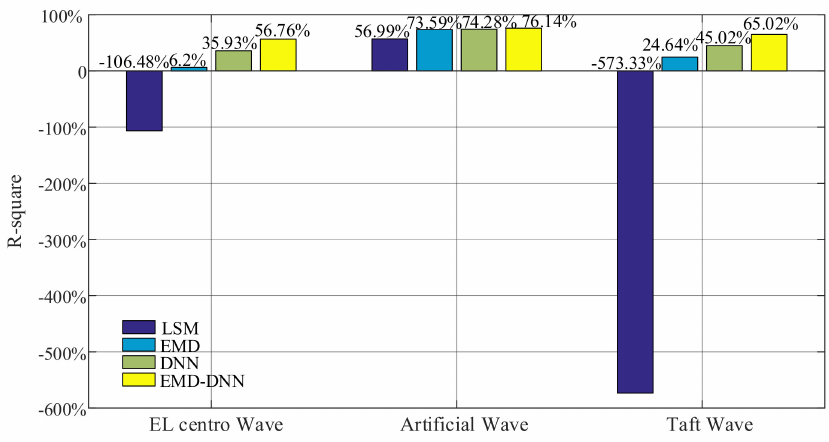
Figure 15. Fitting degree of different correction methods.